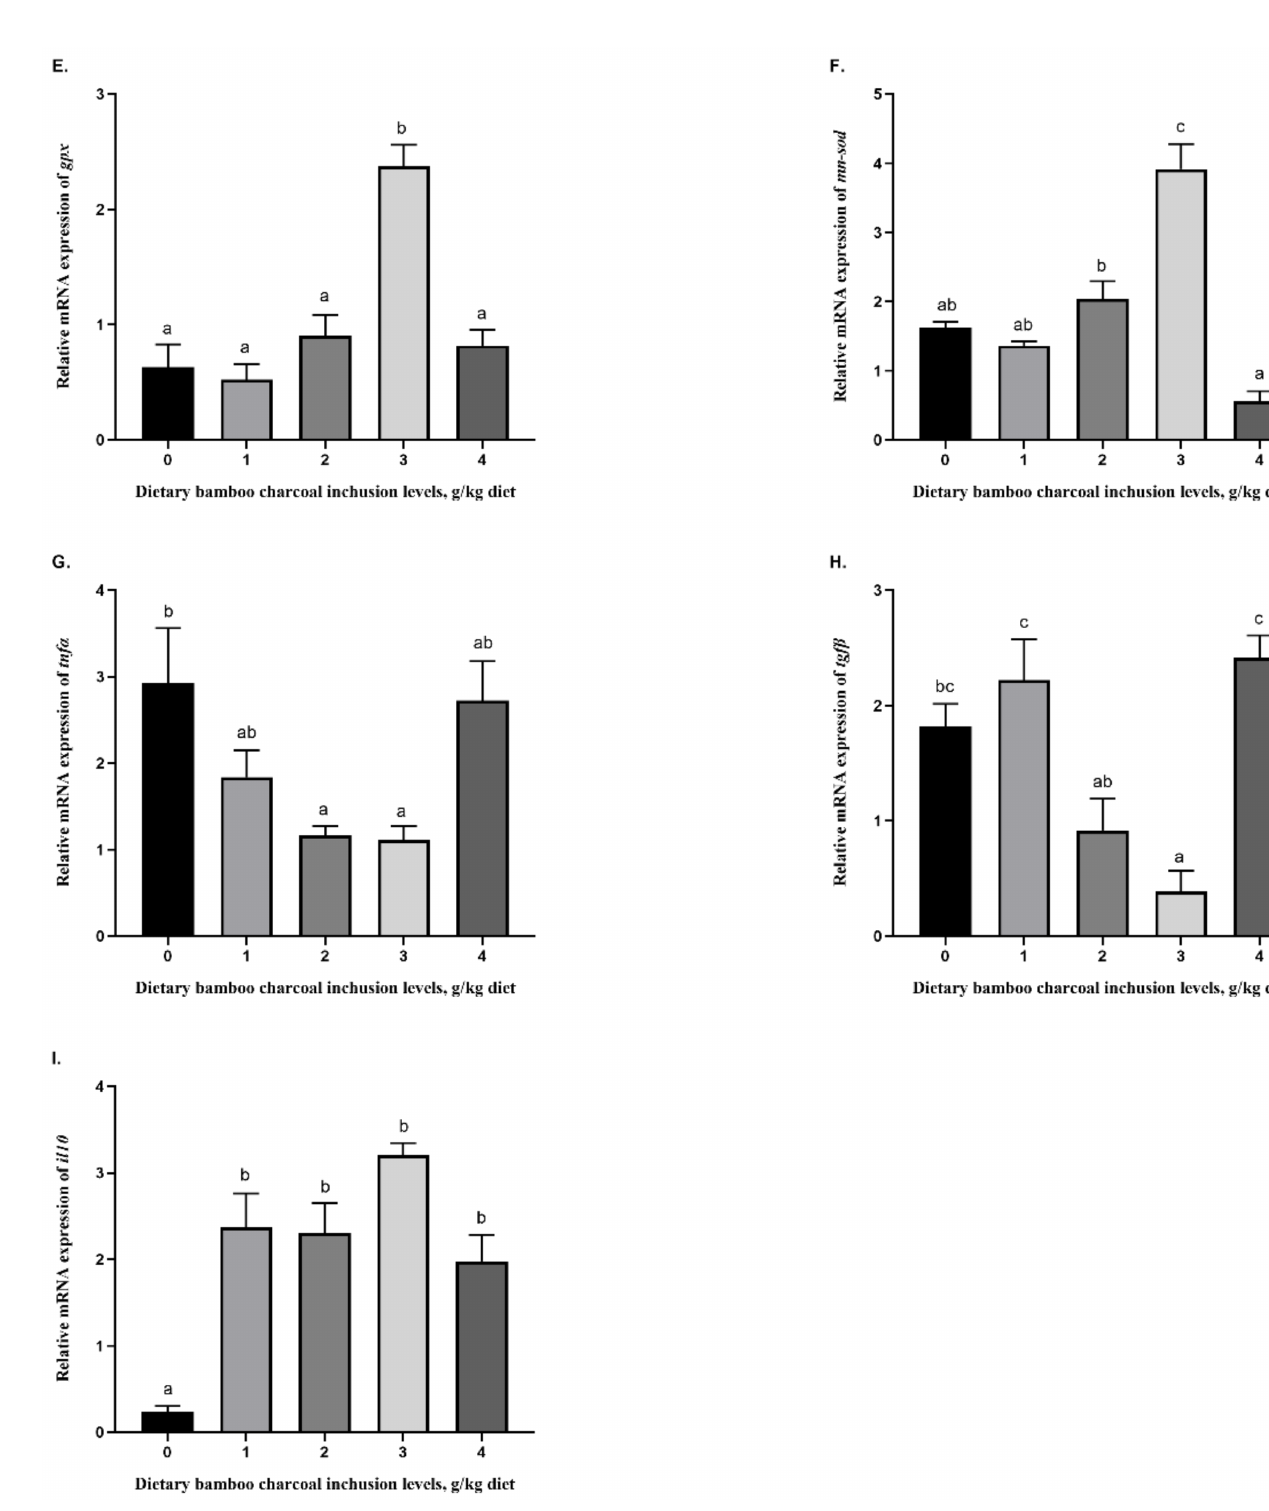
Figure 1. Effects of dietary bamboo charcoal levels on the relative expression of the keap-1 ( A ), nrf2 ( B ), nfkb ( C ), cat ( D ), gpx ( E ), mn-sod ( F ), tnf α ( G ), tgf β ( H ), and il10 ( I ) genes in blunt snout bream liver. All data are reported as means ± SEM ( n = 4). a,b,c: Bars labeled with different superscripts are significantly different from each other according to Tukey’s test ( p <